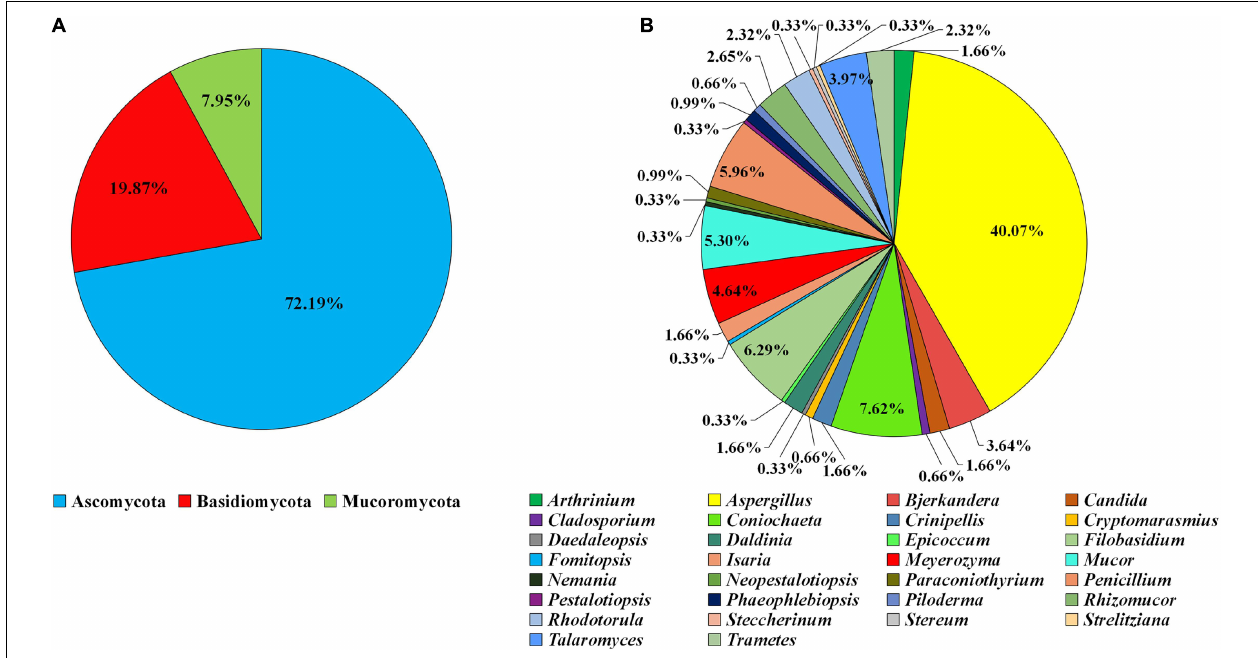
FIGURE 1 | Composition of the filamentous fungal strains isolated from anti-biodegradable residue. (A) The classification was shown at the phyla level. (B) Generic